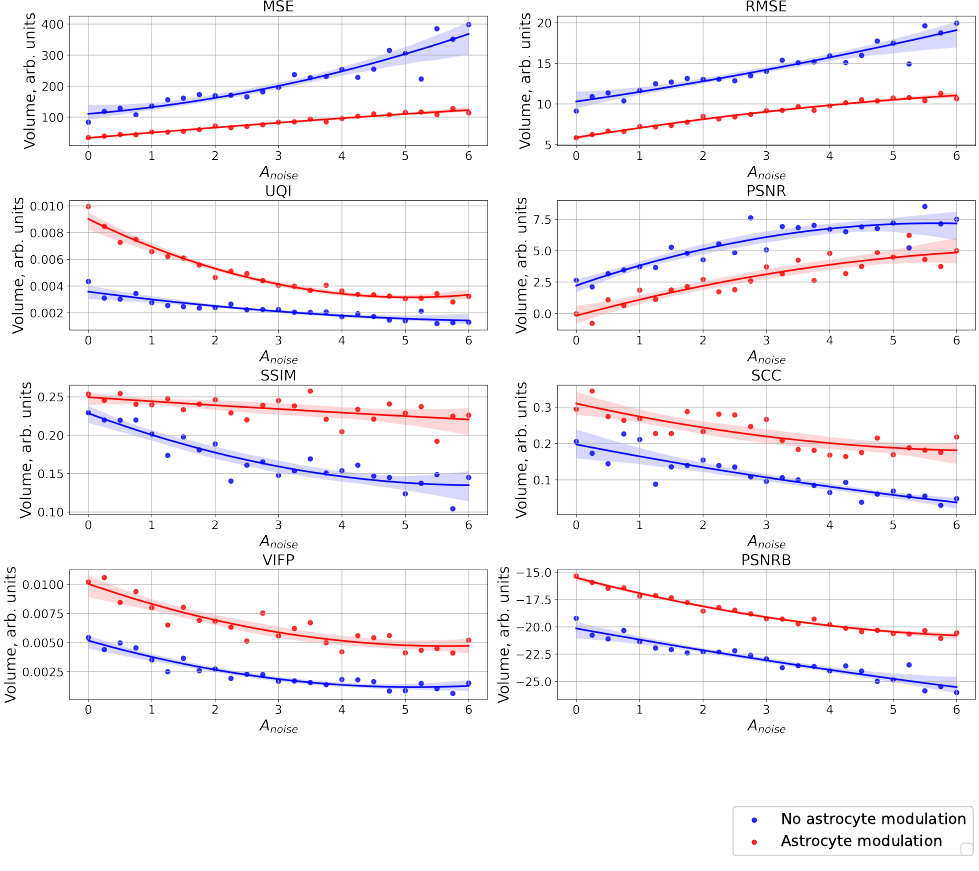
Figure 8. The case of using quality metrics—MSE, RMSE, UQI, PSNR, SSIM, SCC, VIFP, PSNRB—for comparing raster diagrams of neural activity from Figures 5 and 6 with an image (middle panel of Figure 2) fed to a spiking neural network with an increase in the amplitude, A noise , of the noise signal from 0 to 6 supplied to the neurons of the neural network without astrocytic modulation (blue dots and curve) and with astrocytic modulation (red dots and